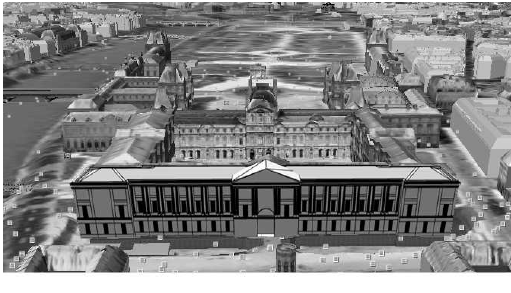
Figure 7: Reconstruction of the “petit conseil’s final design for the East Wing of the Louvre, in the Context of a Google Earth Aerial photo